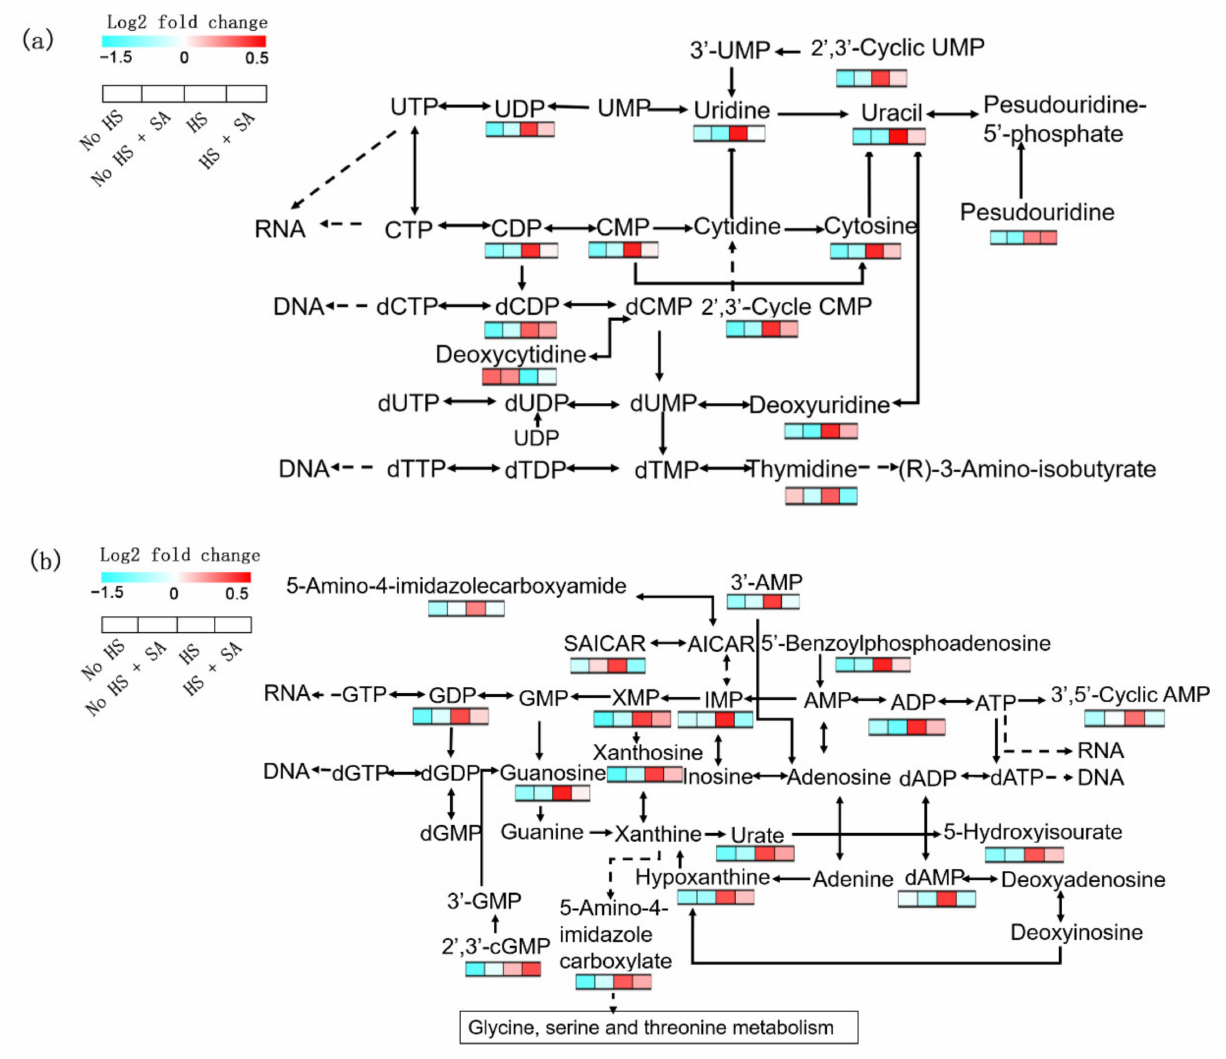
Figure 4. Nucleotide metabolism analysis. ( a ) Pyrimidine metabolism; ( b ) purine